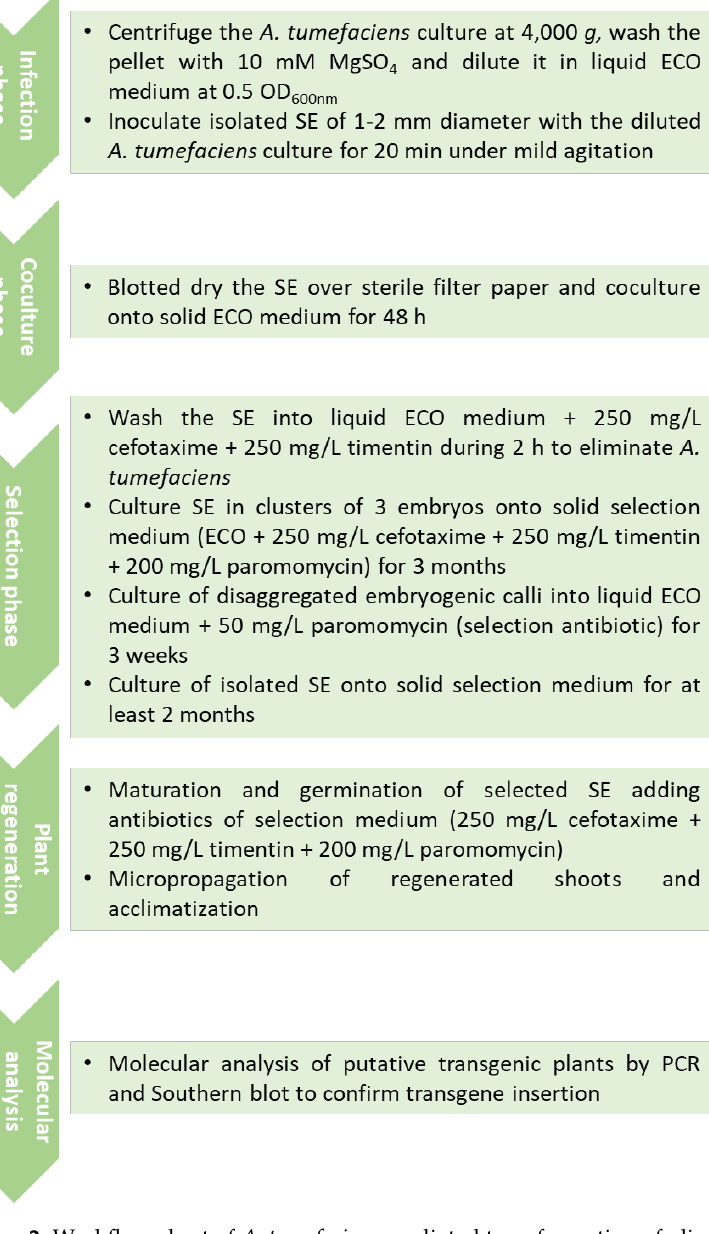
Figure 2. Workflow chart of A. tumefaciens -mediated transformation of olive SE using the protocol described by [56].